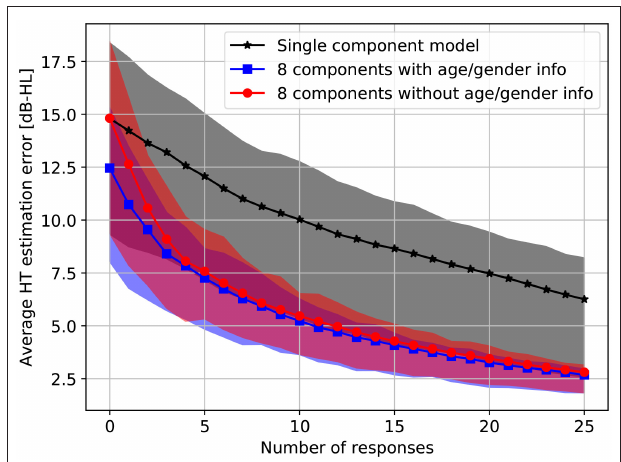
FIGURE 6 | Average absolute HT estimation error on the standard audiometric frequencies (125, 250, 500, 750, 1,000, 1,500, 2,000, 3,000, 4,000, 6,000, 8,000 Hz) as a function of the number of responses under the single-component and 8-component models. The results are averaged over 200 simulations on a random subset of the test set. Shaded areas span from the first quartile to the third quartile. Note that the single-component model cannot be conditioned on age or